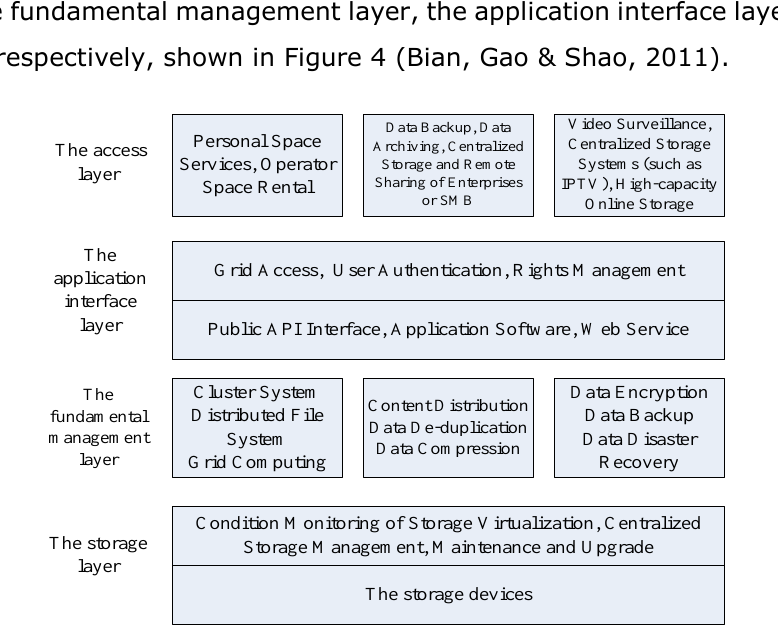
Figure 4. The structural model of the integration information platform of high quality teaching resources in universities based on the cloud storage  The storage layer. The storage layer is the most fundamental part of the cloud